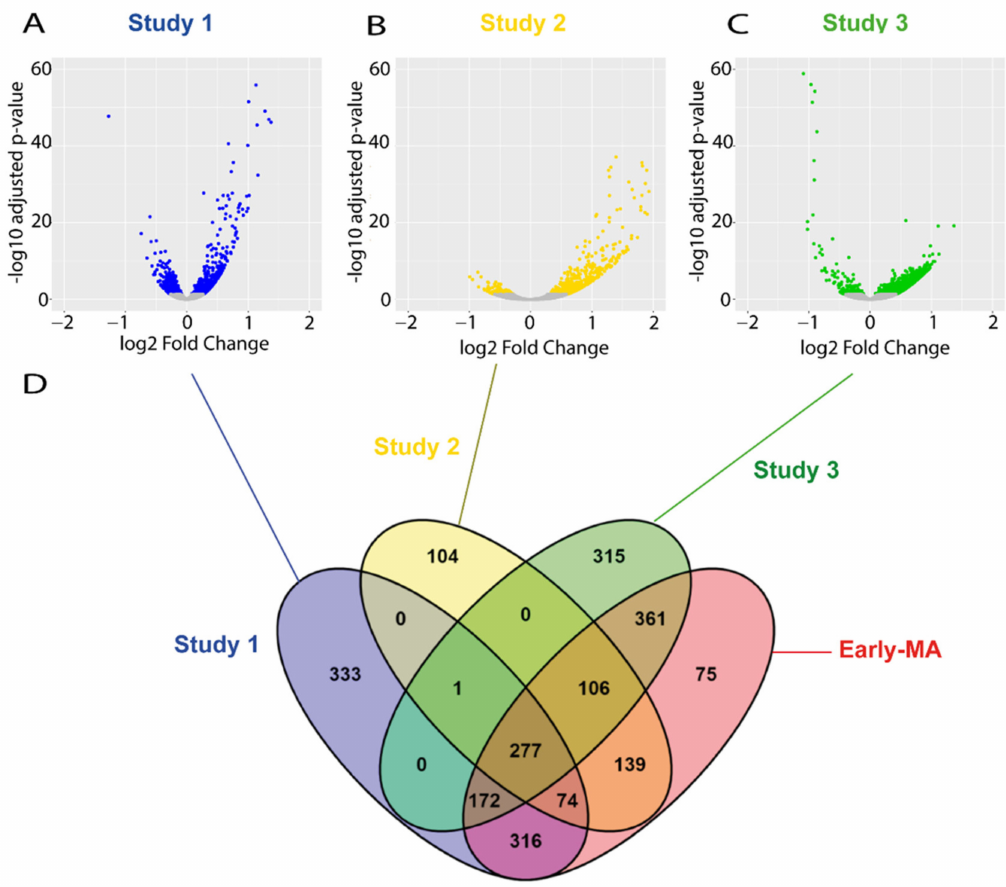
Figure 3. Meta-analysis of early symptomatic RNA-seq studies. ( A – C ) Volcano-plots showing the dysregulated genes found on each of the three RNA-seq studies selected at P90. Blue, yellow, and green dots indicate DEGs found in the study 1, 2, and 3, respectively. Grey dots indicate genes with no significant change. ( D ) A Venn diagram illustrating the overlapping DEGs across the three studies and the result of the meta-analysis (Early MA). The meta-analysis (Early MA) was performed using Fishers combined probability test where raw p-values were adjusted by the Benjamini–Hochberg false discovery rate (FDR) method and the adjusted p-values less than 0.01 were considered as statistically